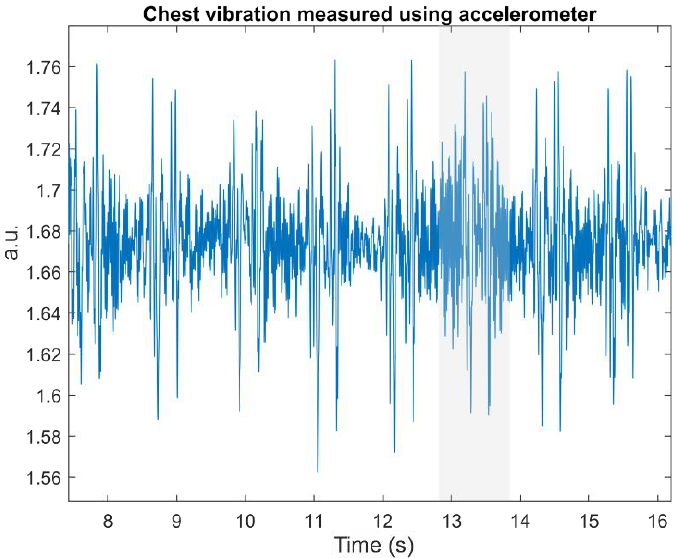
Figure 1. Typical SCG signal measured from the chest. Each heartbeat consists of S 1′ and S 2′ , which are close to each other, like those in PCG. Although the signal under the shaded area, around 13 – 14 s, is corrupted, both S 1′ and S 2′ are still visible.